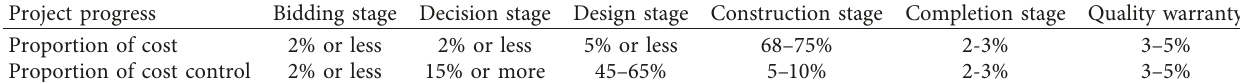
Table 1: Stage cost impact analysis table.